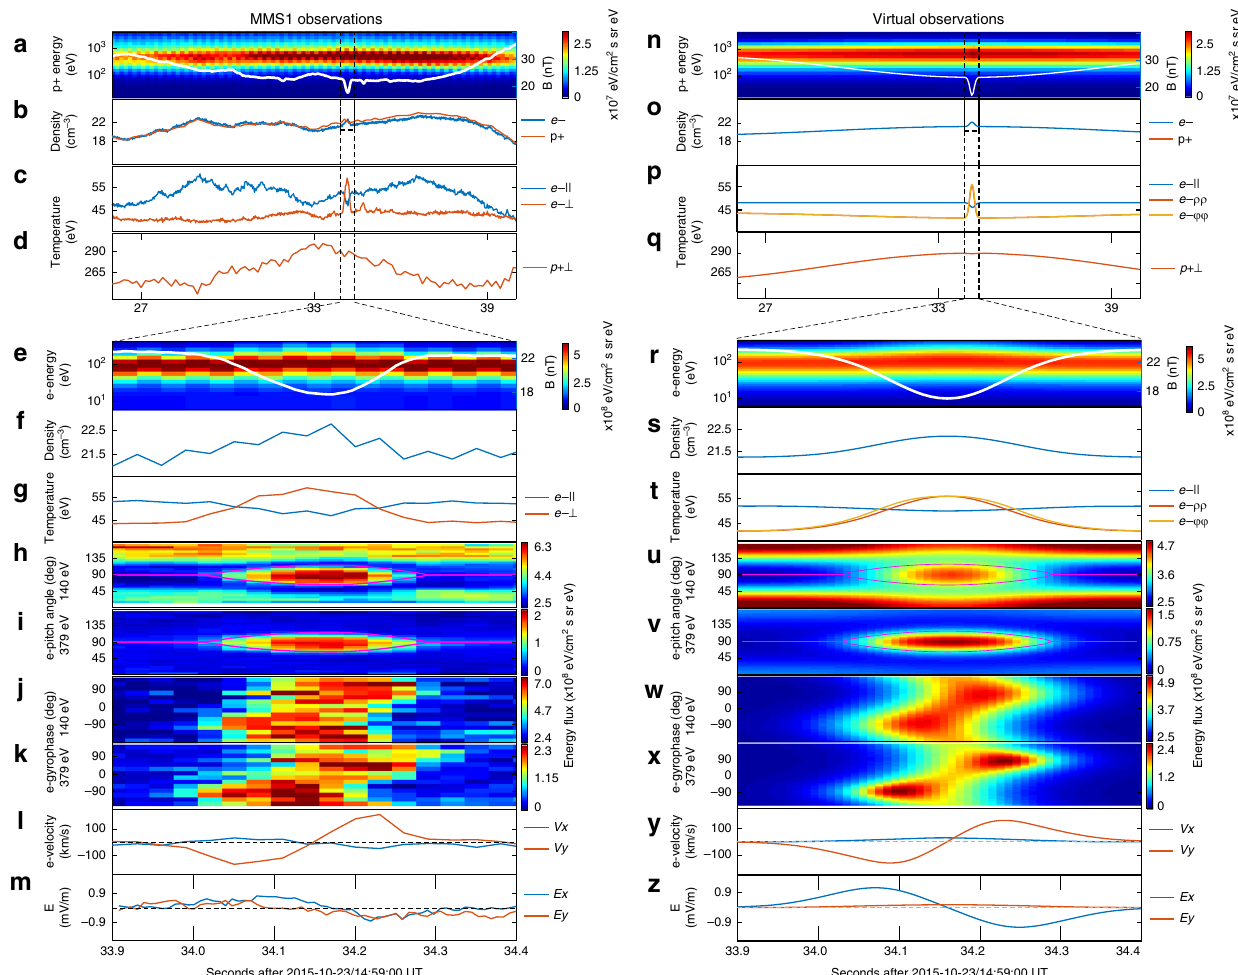
Fig. 1 Comparison between the MMS1 observations of nested magnetic cavities on 23 October 2015 and the virtual spacecraft observations across the equilibrium model. Panels a – d show the MMS1 observations between 14:59:26UT and 14:59:40UT of the magnetic fi eld strength (white line, superposed over the proton energy spectrogram), the plasma density, the electron parallel and perpendicular temperatures, and the proton temperature, respectively. Panels e – m are the zoomed-in view of the electron-scale magnetic cavity within 0.5 s, which show the magnetic fi eld strength (overplotted on the electron energy spectrogram), the electron number density, electron parallel and perpendicular temperatures, the electron pitch angle distributions in the 140- and 379-eV energy channels, the electron gyrophase spectrograms in the same channels, the electron bulk velocity in the rest frame of the proton fl uid, and the electric fi eld (Lorentz transformed into the proton rest frame), respectively. Panels n – z are the virtual spacecraft observations across the modeled magnetic cavities in the same format as in panels a – m . The magenta lines in panels h and i are the “ local loss cones ” , de fi ned in ref. 16 to represent the trapping regimes between two hypothetical mirror points (with the magnetic fi eld strength of 22.3 nT, or the ambient fi eld strength) bracketing the cavity in the fi eld-aligned